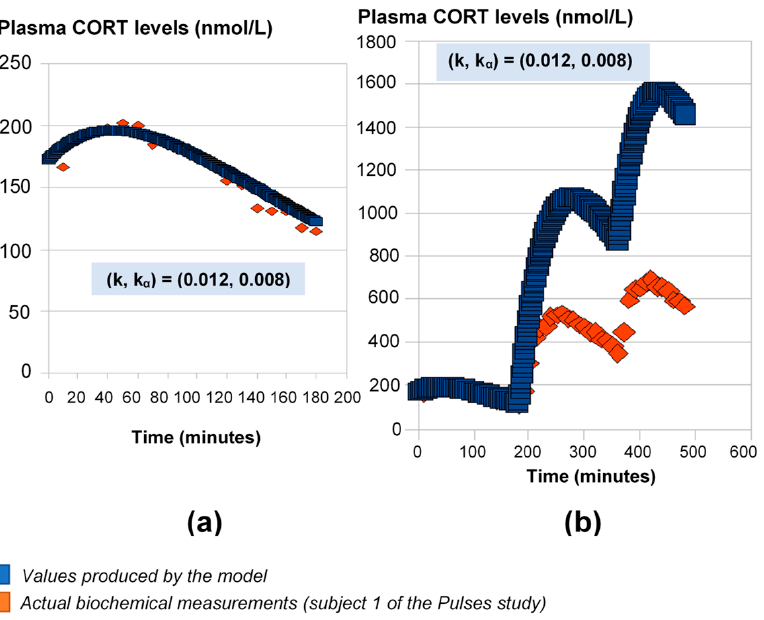
Figure 1. Mathematical model predictions of plasma cortisol levels assuming constant absorption (k α ) and secretion (k) rates. The model fits the data during the first three hours ( a ), but for the estimated (k, k α ) values, it significantly deviates from the observed plasma cortisol values past the first three hours ( b ). Plasma cortisol measurements belong to Subject 1 from the Pulses study (see Materials and Methods). CORT: cortisol.